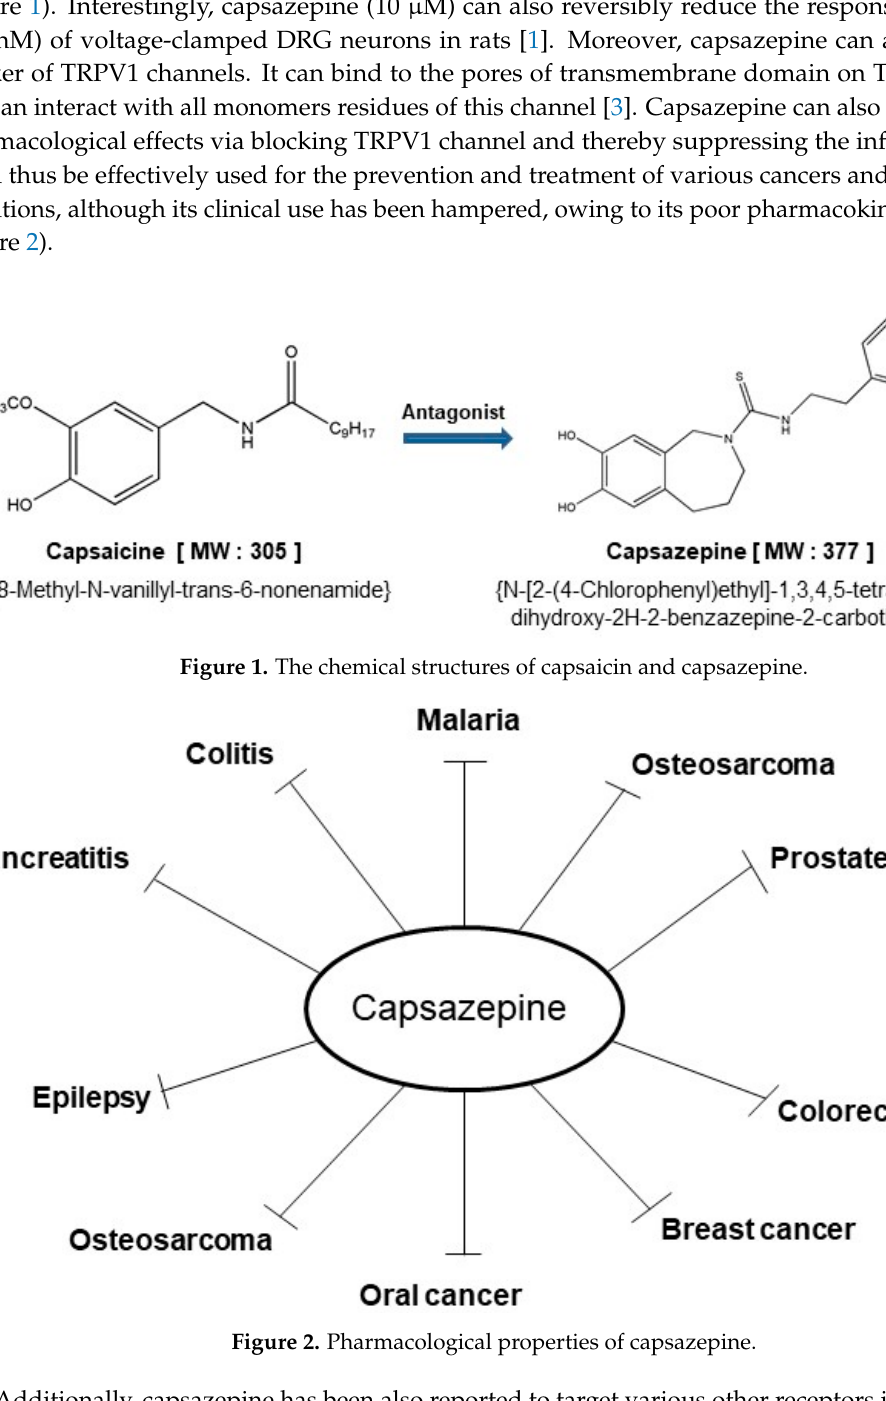
Figure 2. Pharmacological properties of capsazepine.